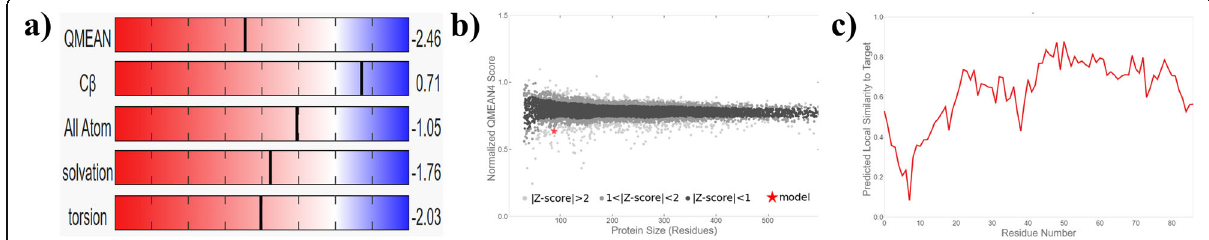
Fig. 4 Quality assessment of modelled EhApc11 structure by QMEAN server. a Global quality estimation. b z -score value ( − 2.46) of EhApc11 shown as a red star. c Local quality estimation. QMEAN scoring function depends on four individual components. Local geometry analysis is based on the potential of torsion angle over three consecutive amino acids. Long-range interactions are assessed at the residue level and at the second level based on the potential of C β atoms and all atoms, respectively. Solvation energy is calculated to know the accessibility of residues to water. The QMEAN z -score of − 4.0 or below is an indication of low model quality. The QMEAN z -score is shown on top, and individual z -scores are displayed below. The local quality plot is interpreted as the possibility of each residue of the model (on the x -axis) to be similar or deviable to the available native structures (on the y -axis). Residues with a score below 0.6